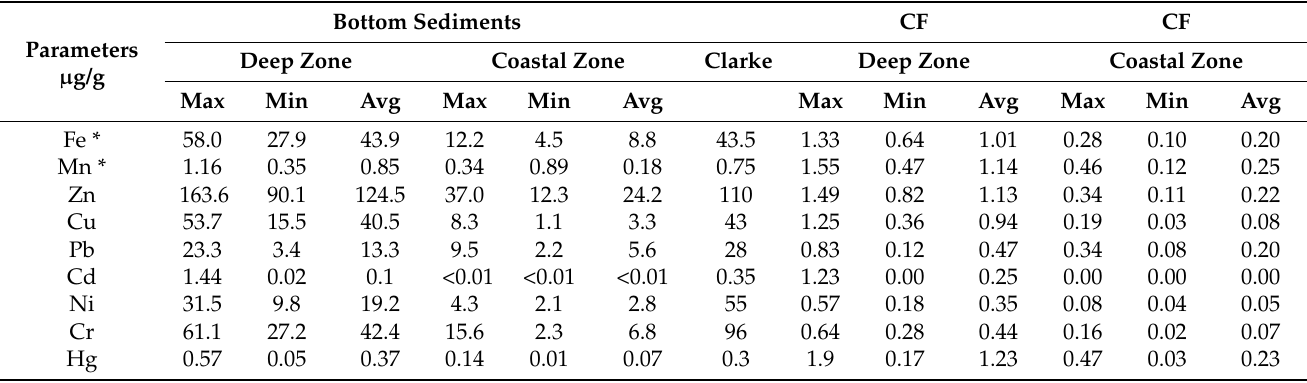
Table 4. The maximum, minimum and average content of chemical components in the BSs of Lake